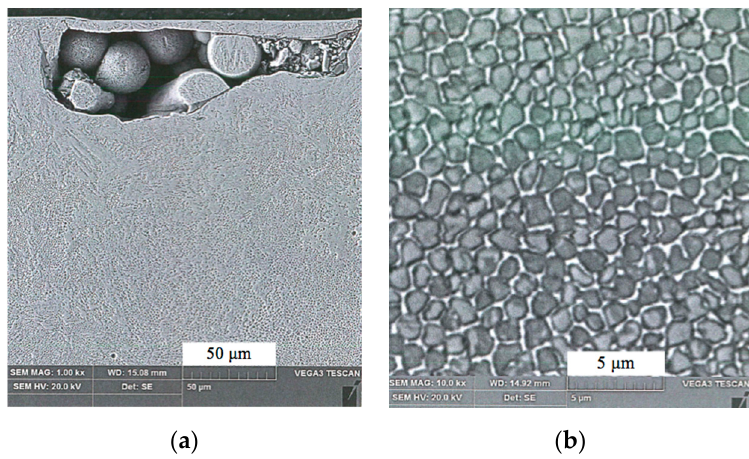
Figure 9. SEM images of microstructure: ( a ) example of the unmolten particles; ( b ) grained microstructure of the sample 3.